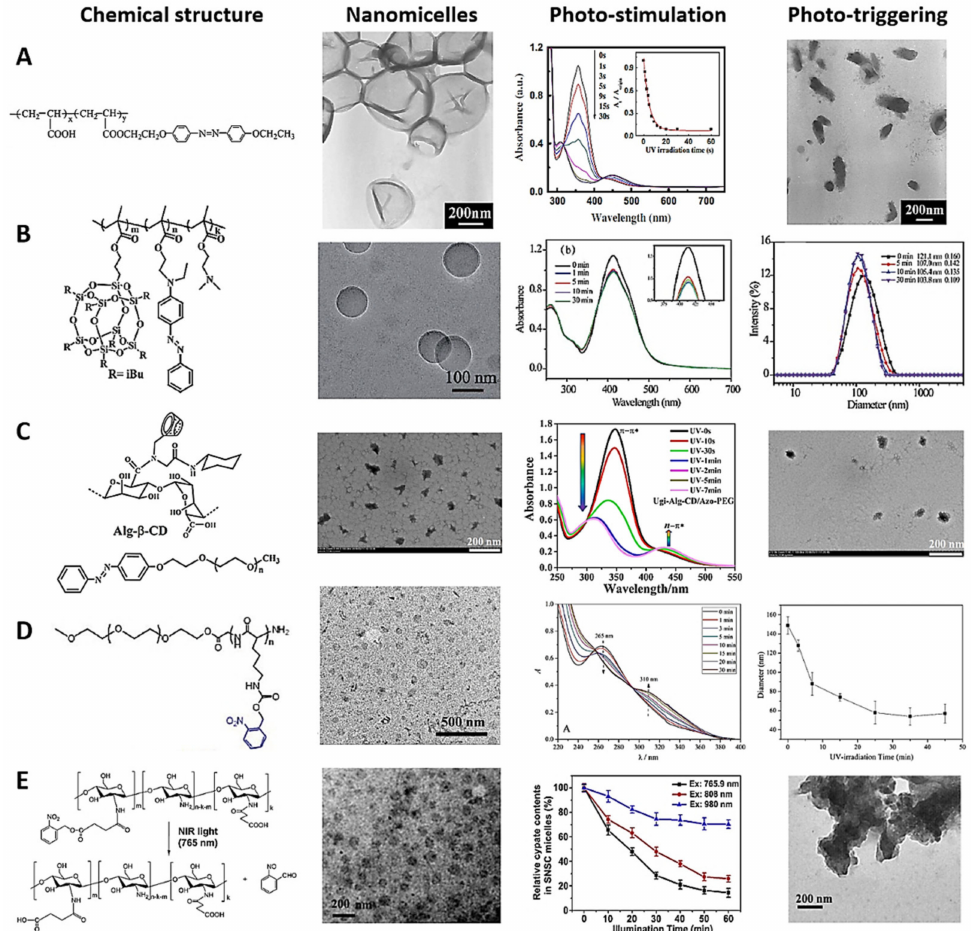
Figure 5. Chemical structure, TEM images, photostimulation, and phototriggering characterization of photosensitive nanomicelles. Study of PNMs based on ( A ) PPAPE, ( B ) copolymer based on methacry- late isobutyl polyhedral oligomeric silsesquioxane and azobenzene derivatives, ( C ) amphiphilic Pickering emulsion, ( D ) poly(o-nitrobenzyloxycarbonyl-L-lysine)-b-PEO, and ( E ) o-nitrobenzyl N- succinyl chitosan polymer. Reprinted with permission from [149,180,211–213]. Copyright 2012, Elsevier; 2018, Royal Society of Chemistry; 2021, Elsevier; 2017, Royal Society of Chemistry; and 2013, Elsevier,